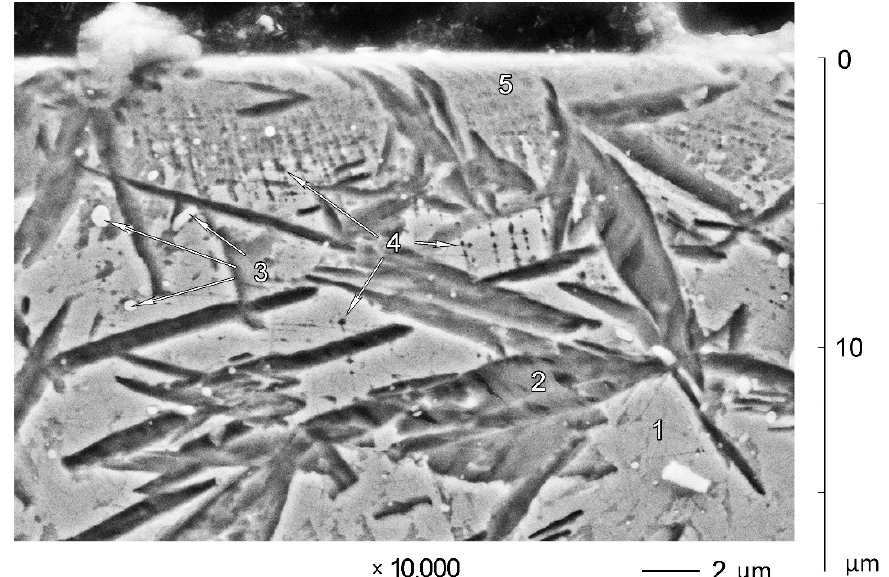
Figure 4. Microstructure of subsurface zones of X120Mn3Si2 steel after quenching from 900 °C and wear in A mode: 1—austenite; 2—martensite; 3—carbides; 4—etch pits; 5—surface zone formed by abrasive wear.